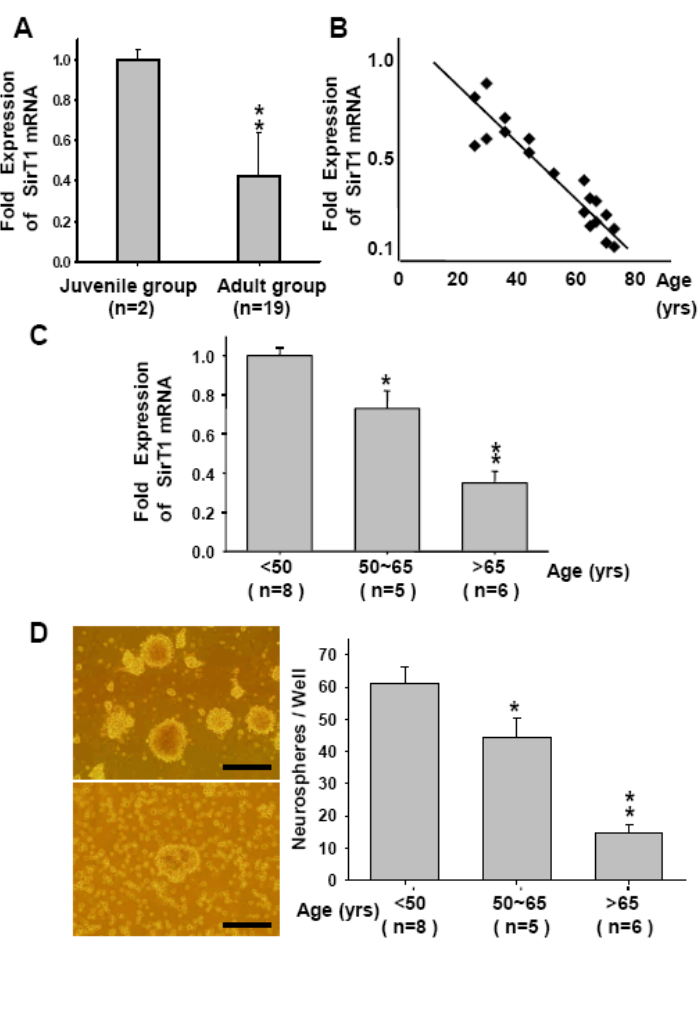
Figure 3. Detection of SirT1 mRNA in RSC isolated from the posterior ciliary margin of human donor. (A) The SirT1 mRNA expression level detected by qPCR in RSCs from adult groups (n = 19) was significantly decreased compared to that in RSCs from juvenile group with donor age younger than 10 years old (n = 2, **p < 0.01). (B) The regression plot showed that the SirT1 level was negatively correlated with age in RSCs. (C) Human samples were divided into three groups based on age. The bar chart demonstrated that the SirT1 mRNA level was significantly decreased with age. (D) Neurospheres formation showed increased in patients younger than 50 years old (left upper) than those older than 65 years old (left lower). Bar: 100 μm. Data shown here are the mean  SD of three